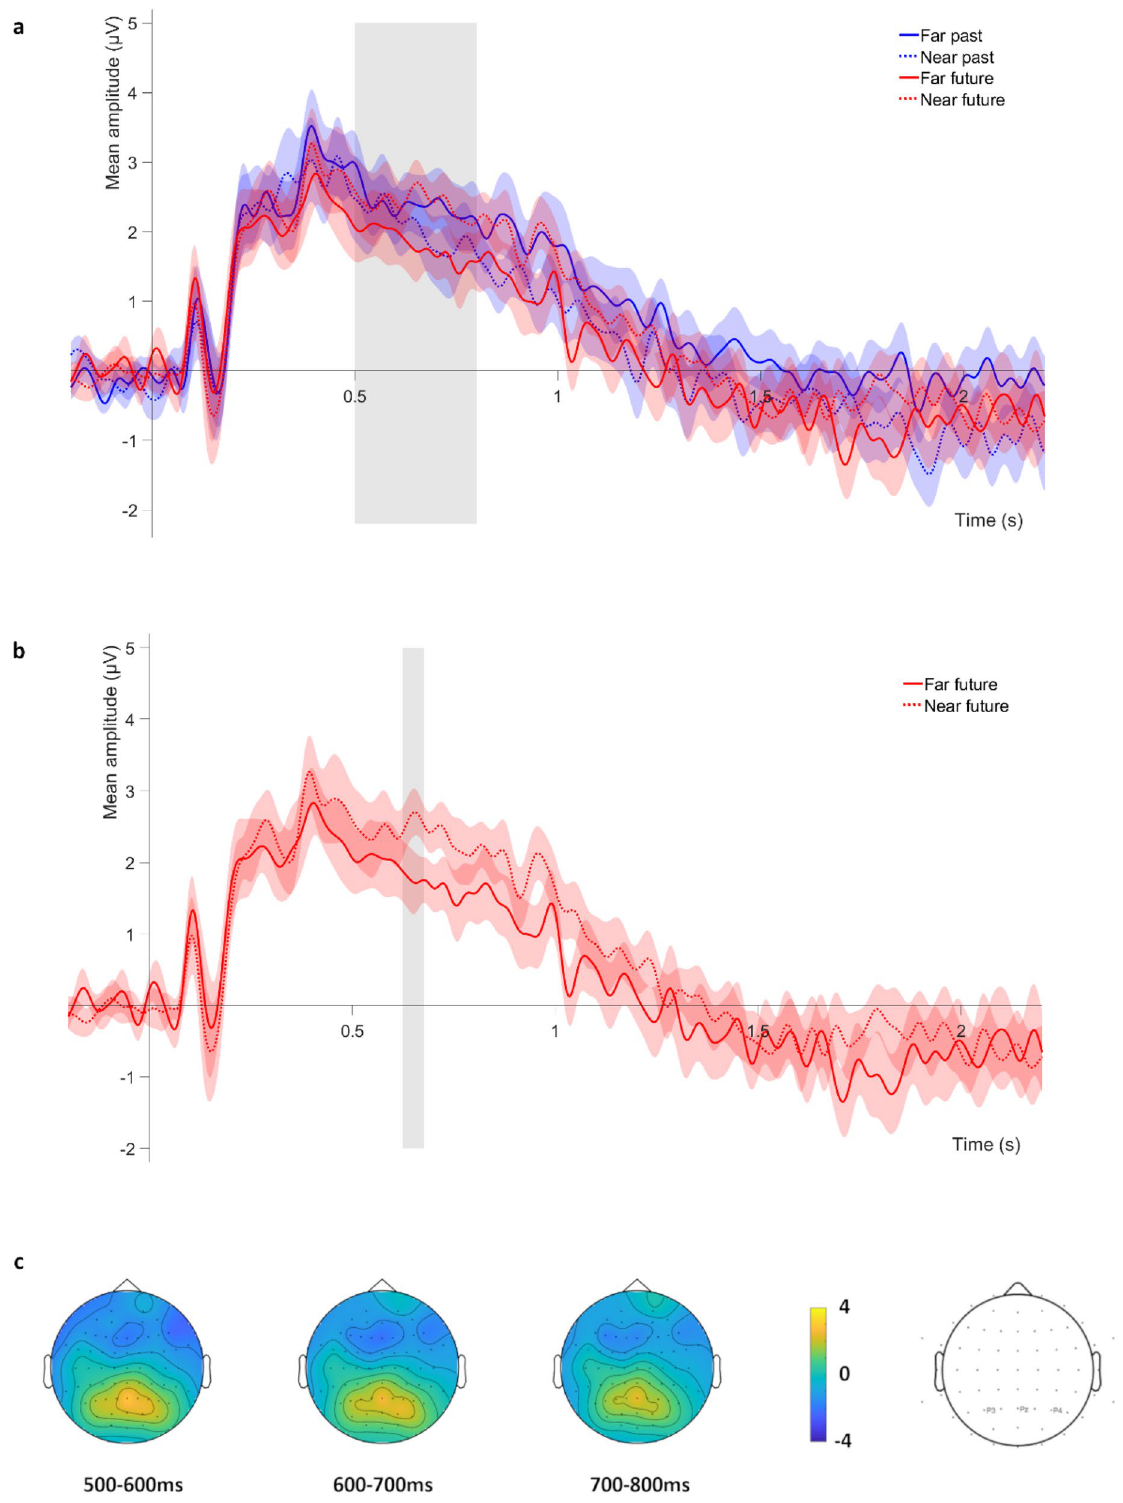
Figure 2. Electrophysiological data for the LPC time window. ( a ) Mean amplitude of the ERP averaged across the three electrodes selected for the LPC analyses (P3/4 and Pz). The grey rectangle shows the time window of this component (from 500 to 800 ms). ( b ) Far future vs near future comparison for the LPC, grey rectangle shows the cluster of time points for which the comparison was significant. For ( a ) and ( b ), shadowed regions indicate the standard error of the mean for each experimental condition. ( c ) Scalp map of the LPC for the mean average of all experimental conditions, showing the temporal course of this